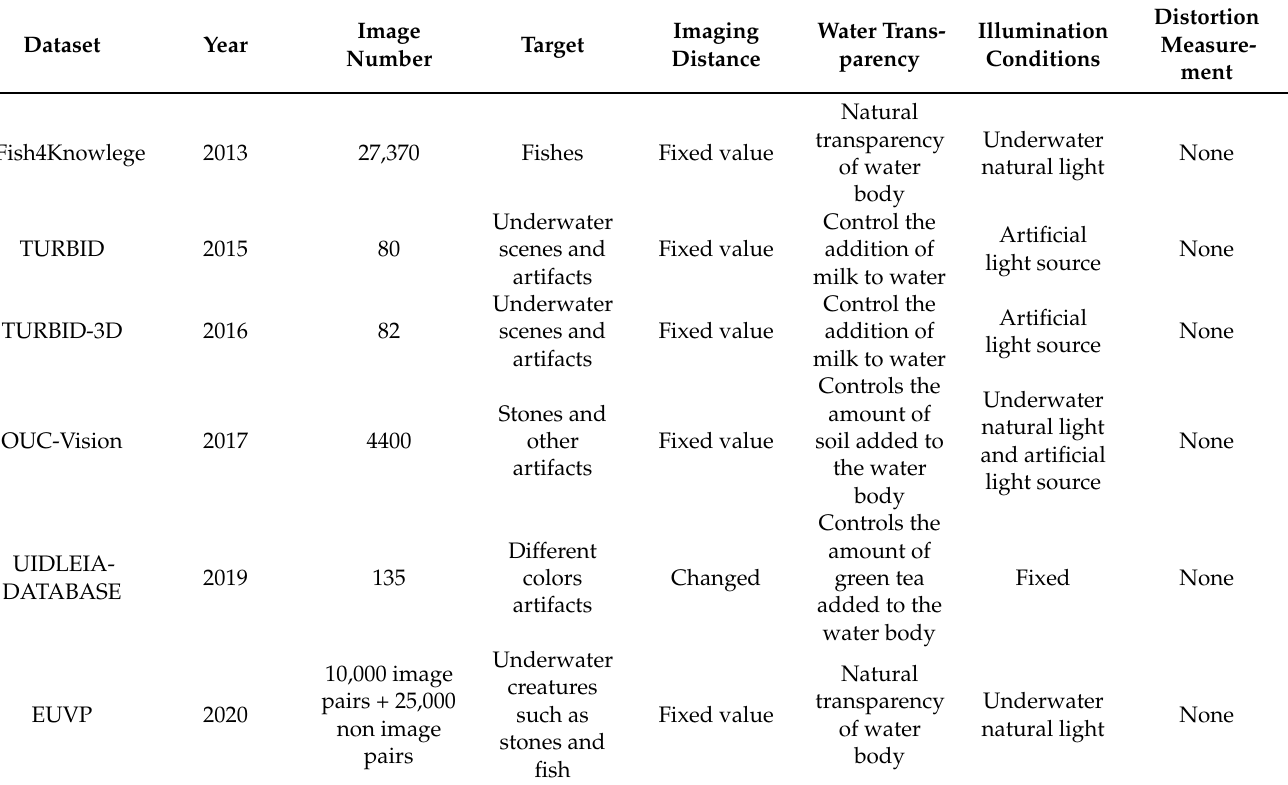
Table 1. Comparison of partial underwater image